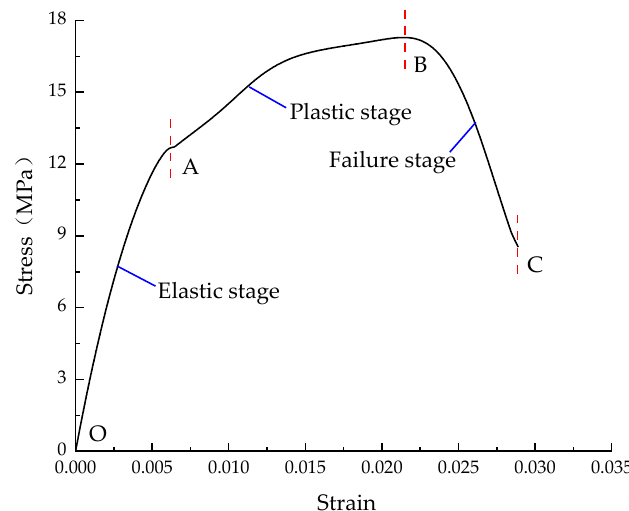
Figure 5. Typical dynamic stress–strain relationship curve.